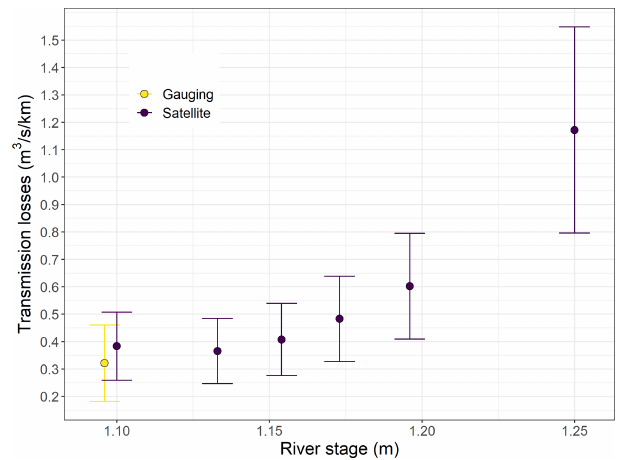
Figure 8. Selwyn River transmission losses estimated using differ- ential gauging (“Gauging”, yellow) and river drying front locations identified on satellite imagery (“Satellite”, purple) as a function of the river stage during the September 2020 selected